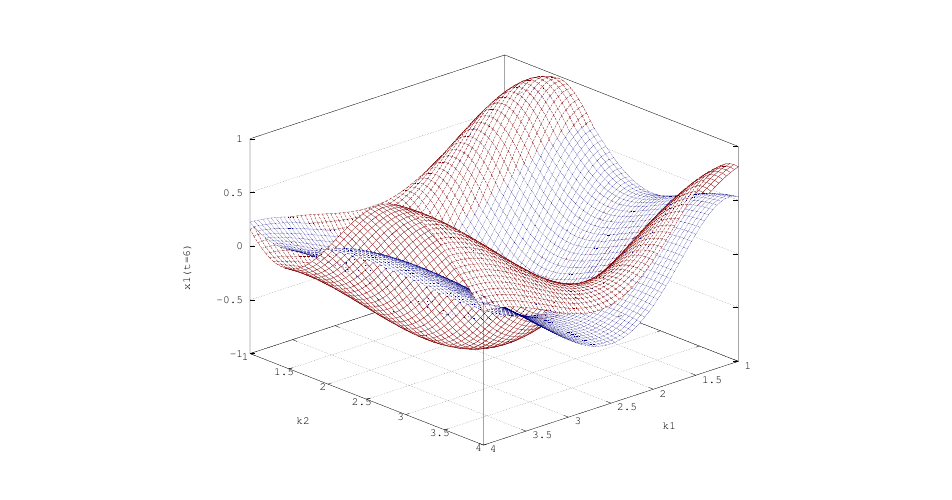
Figure 9. x 1 ( t = 6 ) when 1